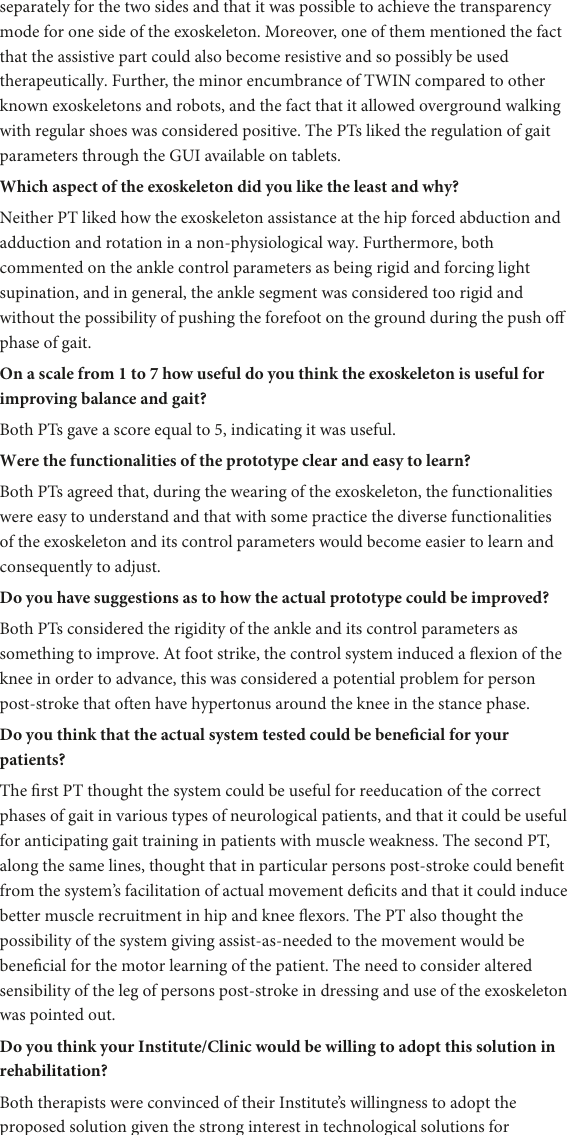
Which aspect of the exoskeleton did you like the most and